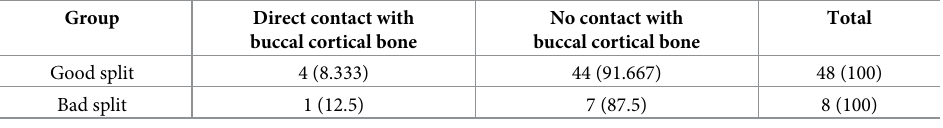
Data are shown as number of patients